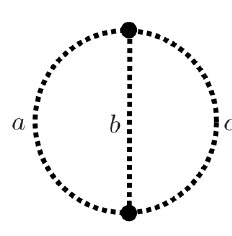
Figure 1. The graph θ ( a , b , c ) , where a + b + c = n + 1. Each dotted line represents a chain with the indicated